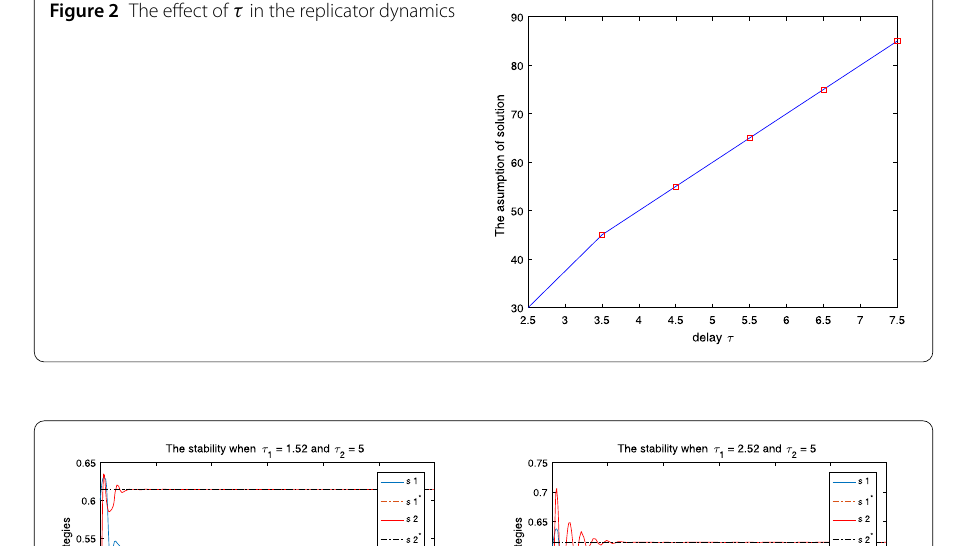
Figure 2 The effect of τ in the replicator dynamics